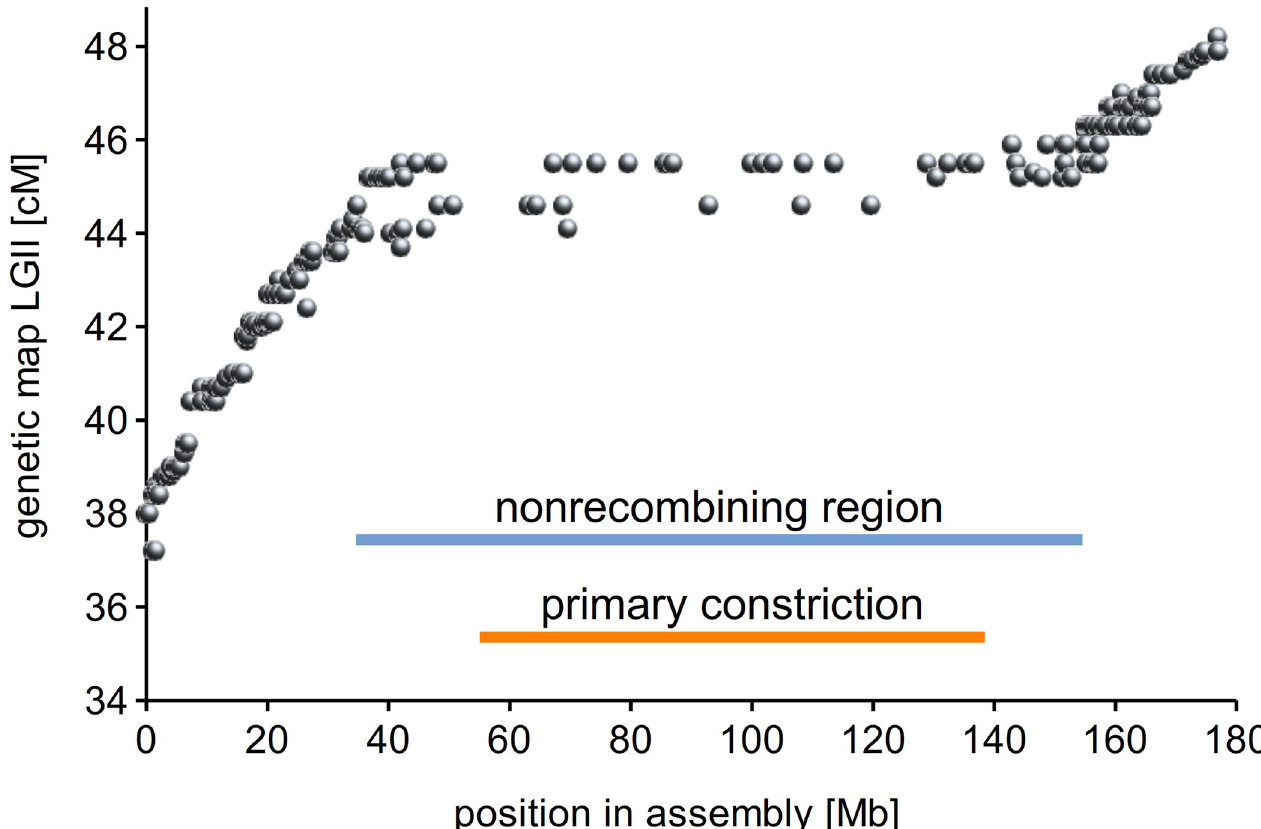
Fig 2. The primary constriction coincides with a region of reduced meiotic recombination. The graph shows the location of genetic marker sequences in the CEN6 assembly compared to their position in the linkage group LGII of the pea genetic map [22].